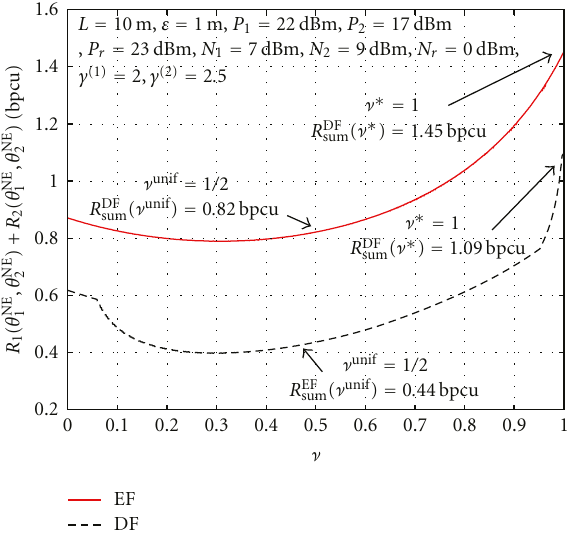
Figure 7: EF versus DF relaying protocol. Achievable network sum- rate at the NE as a function of ν ∈ [0,1] for L = 10 m, ε = 1m, P 1 = 22dBm, P 2 = 17dBm, P r = 23dBm, N 1 = 7dBm, N 2 = 9dBm, N r = 0dBm, γ (1) = 2 . 5, and γ (2) = 2. The optimal relay PA ν ∗ = 1 is in favor of the better user and outperforms the uniform relay PA ν = 0 . 5 for both EF and